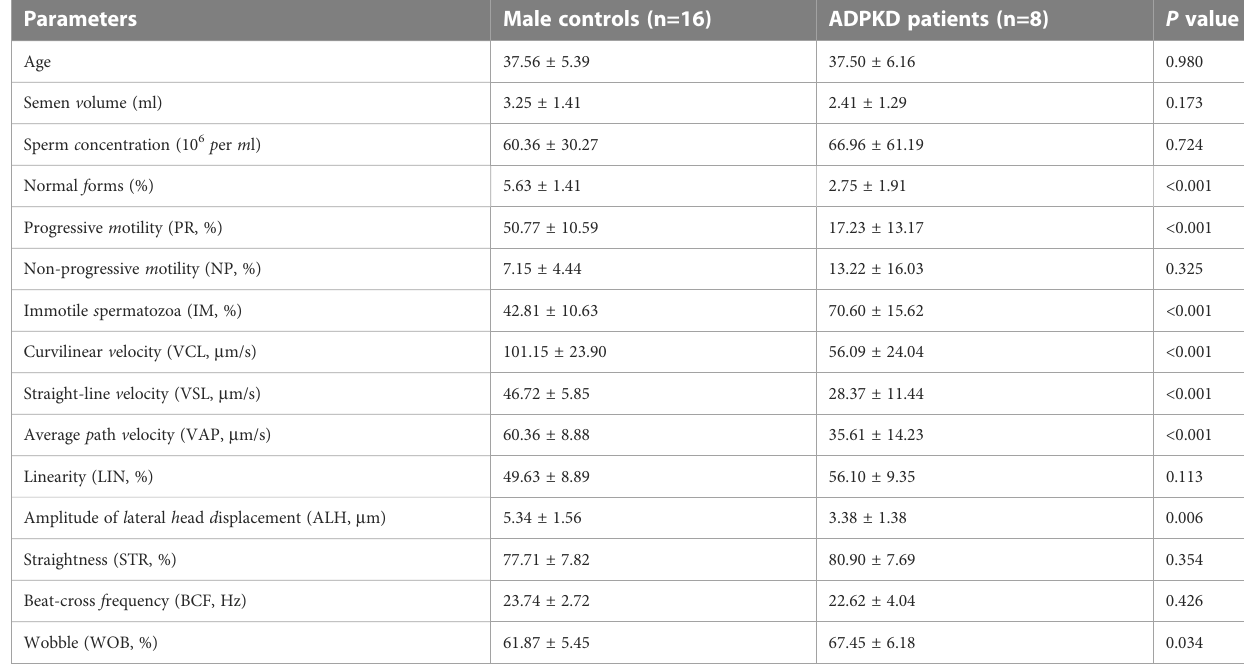
TABLE 2 Sperm characteristics of ADPKD patients and age-matched healthy